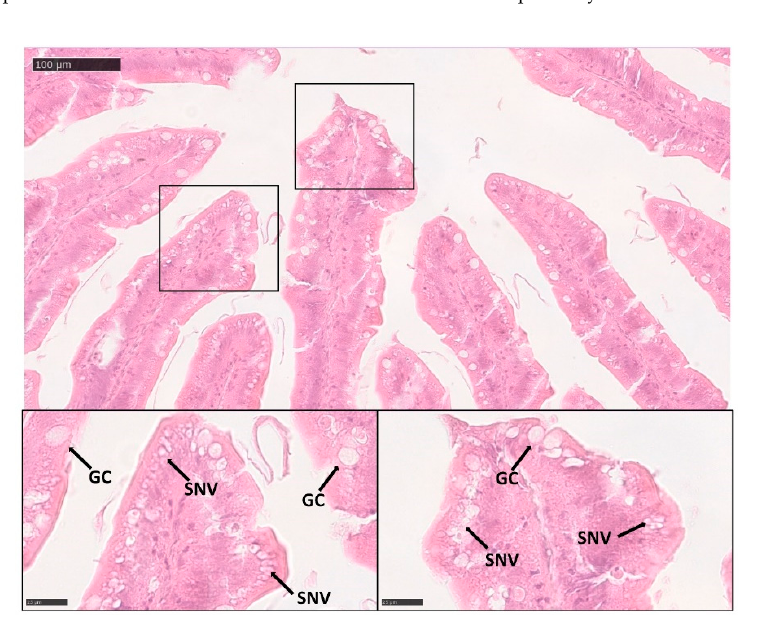
Table 3. Evaluation of proximal intestine histometry in rainbow trout along the first year of development